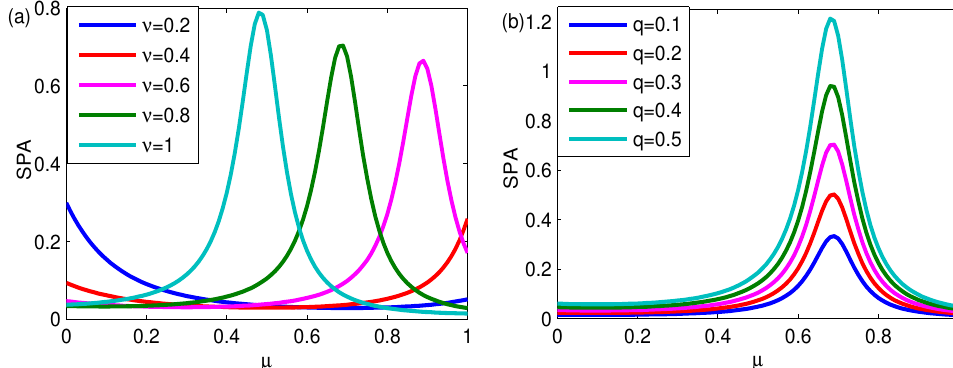
Figure 8. GSR behaviors of SPA( µ ) in (35) for different ( a ) ν and ( b ) q . ( a ) ¯ γ = 0.1, α = 1.2, β = 0.2, δ = 1.6, τ = 0.2, λ = 0.6, a 2 = 0.6, q = 0.3, Ω = 2, ω 0 = 1; ( b ) ν = 0.8, α = 1.2, β = 0.2, ¯ γ = 0.1, δ = 1.6, τ = 0.2, λ = 0.6, a 2 = 0.6, Ω = 2, ω 0 = 1.